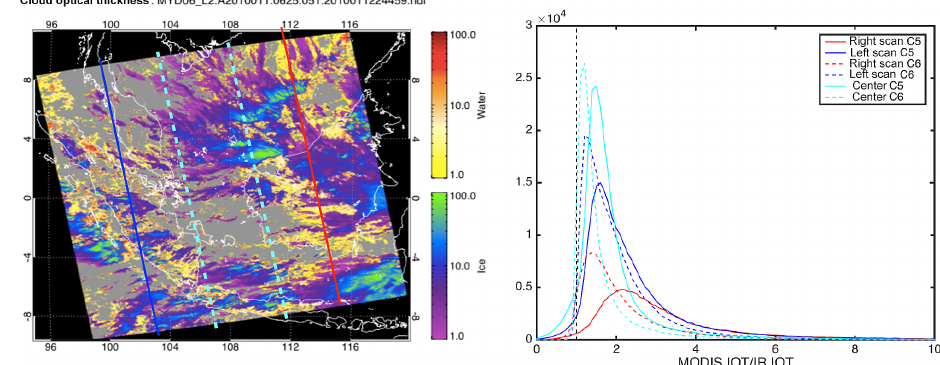
Figure 4. The MODIS IOT retrievals dependence on scan angle is investigated in the above panels. The image presents the MODIS C5 IOT retrievals on 11 January 2010 at 06:25UTC. The right panel presents a histogram of the ratio between the MODIS IOT for both C5 (solid line) and C6 (dashed line) and full-swath IR retrieval for only those FOVs which were identified as ice by MODIS. The histograms are separated by view angle the approximate regions for each color marked by the associated color lines on the left image. Note the significant scan-dependent bias relative to the IR IOT for the MODIS C5 retrievals.